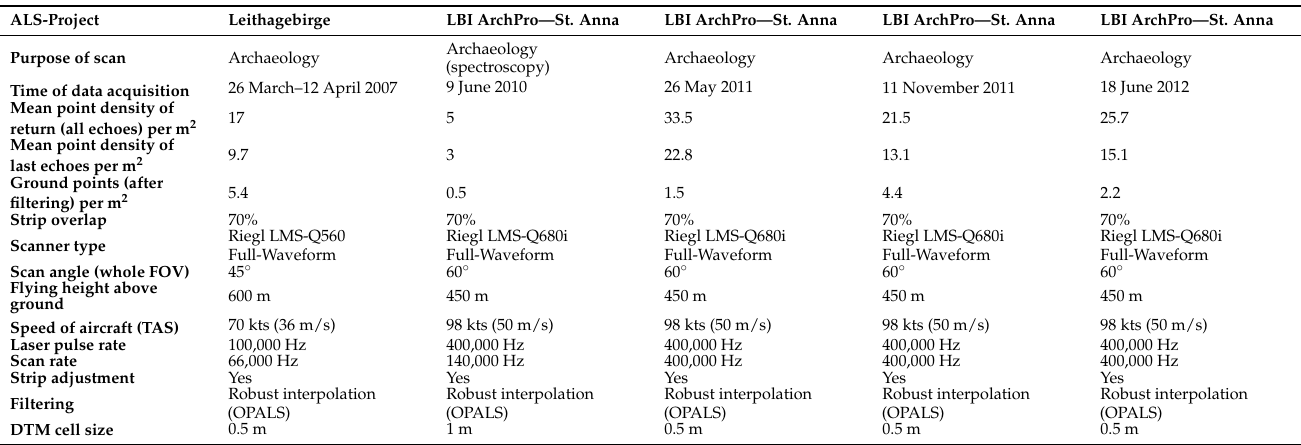
Figure 3. Coverage of individual ALS surveys. Table 1. Parameters of all ALS flights used in this paper.